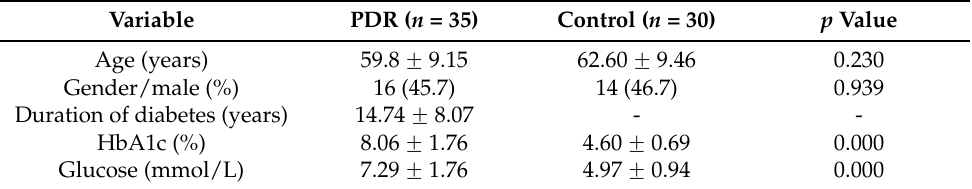
Table 1. Patient characteristics.